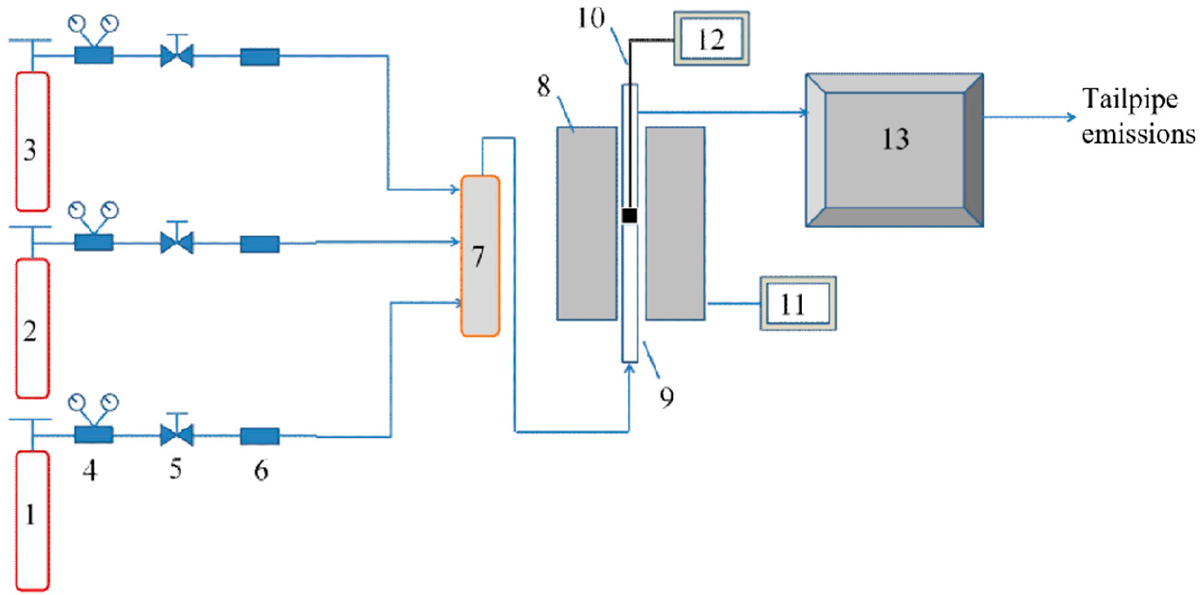
Figure 1. Catalyst methane catalytic combustion activity evaluation device diagram. 1. Ar; 2. O 2 ; 3. CH 4 /CO; 4. Reduction Valve; 5. Stop Valve; 6. Mass Flowmeter; 7. Gas Mixing Tank; 8. Tube Heat- ing Furnace; 9. Quartz Reactor; 10. Thermocouple; 11. Temperature Controller; 12. Digital Indica- tor; 13. Gas Chromatograph.